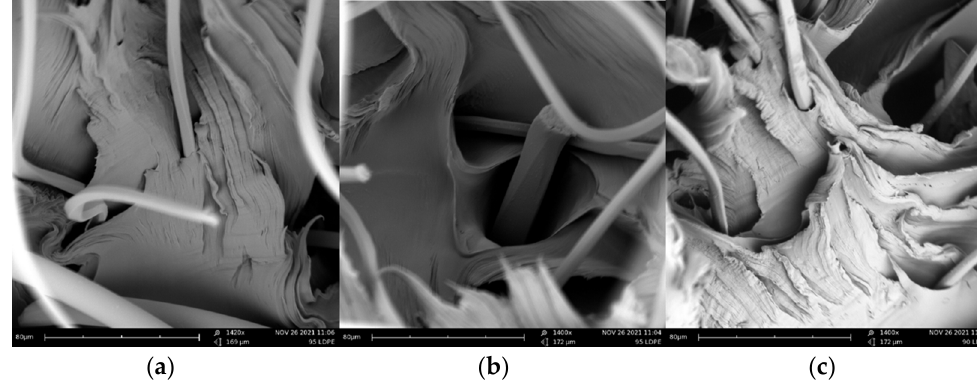
Figure 4. SEM images of the composites at ×1400: ( a ) and ( b ) composite of 5% PES-MFs; ( c ) composite of 10% PES-MFs.